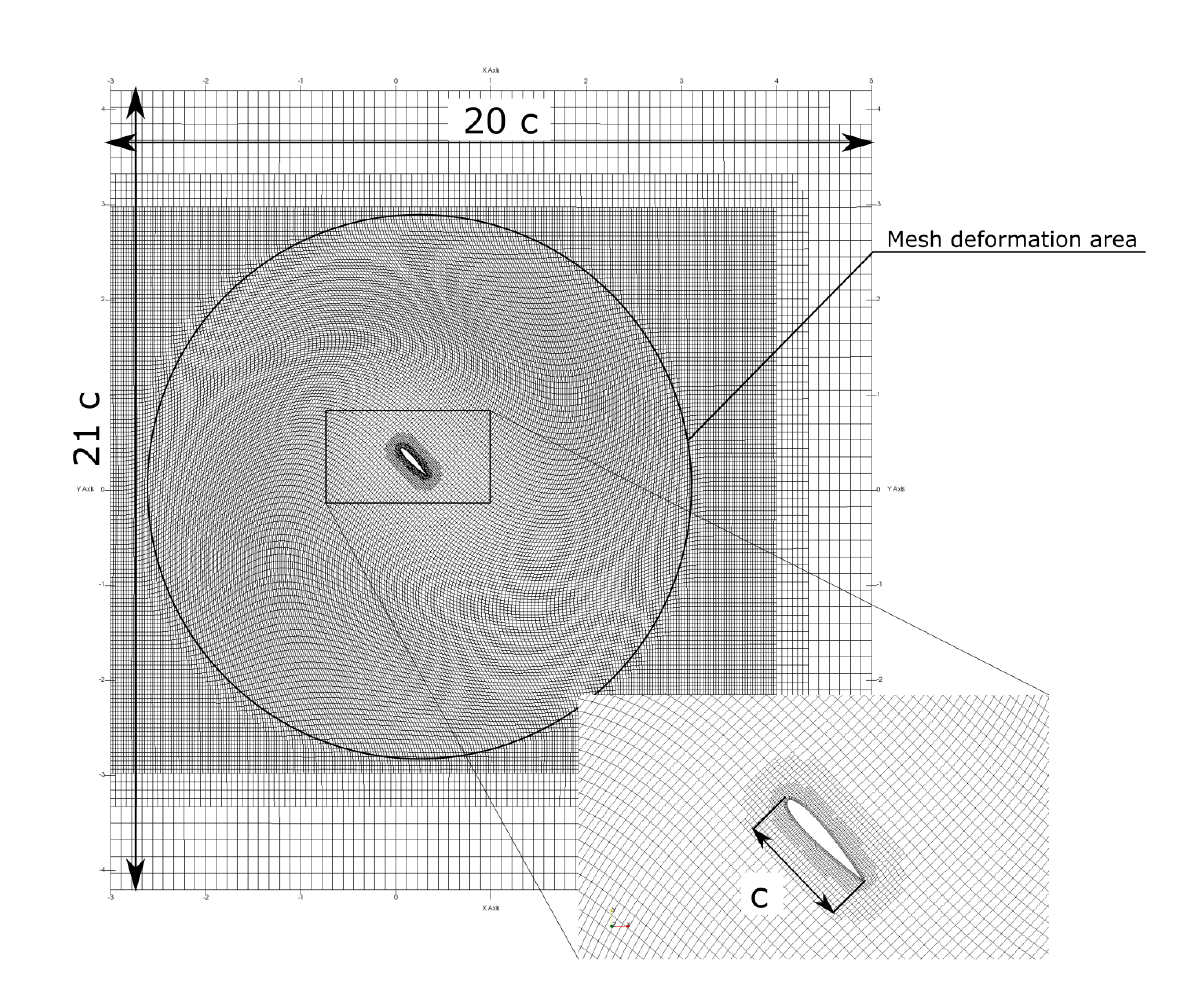
Figure 2. Mesh configuration: to the center, the airfoil and the first two internal mesh regions, which are are zoomed-out in the box to the lower right. The circular mesh deformation area is also shown (deformable mesh). The domain boundaries are indicated in units of chord size. The deformable region is contained in a refinement region, which can contain different levels of